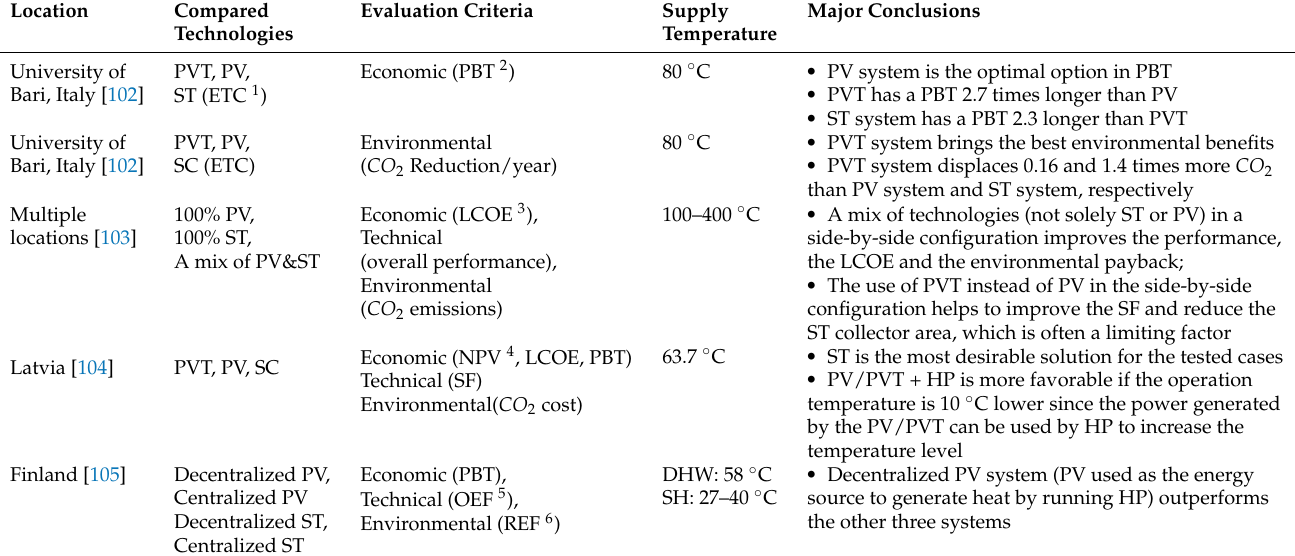
Table 5. Review on the comparison of different solar technologies in some DH systems